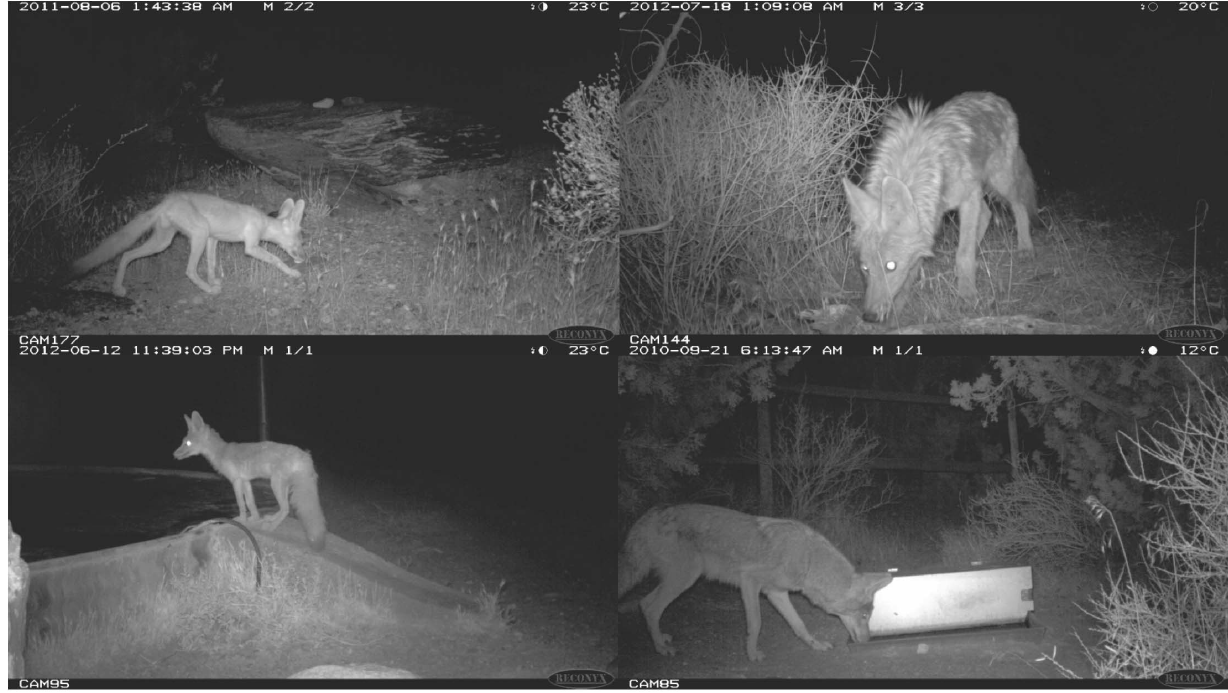
Figure 1. Photo captures of canids from infrared-triggered cameras. Clockwise from top left: kit fox ( Vulpes macrotis ) at a scent station, coyote ( Canis latrans ) at a scent station, coyote at a water development, and kit fox at a water development. Data were collected in the Great Basin and Mojave Deserts, USA, 2011 to 2012. doi:10.1371/journal.pone.0067800.g001 PLOS ONE |